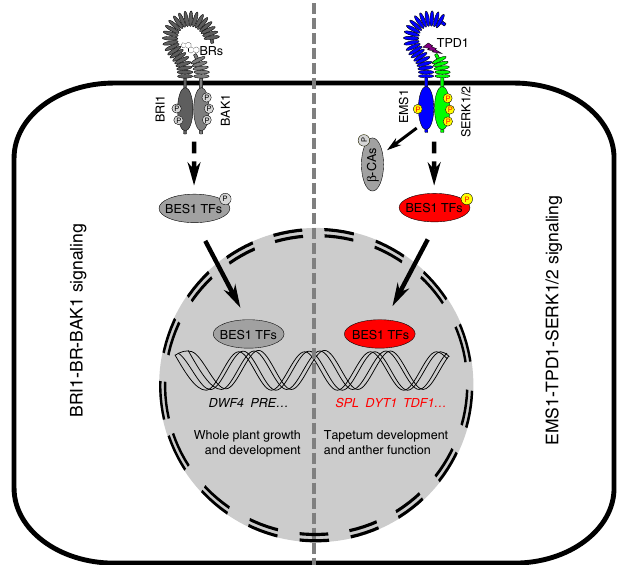
Fig. 8 A current model showing that BES1 family members (or